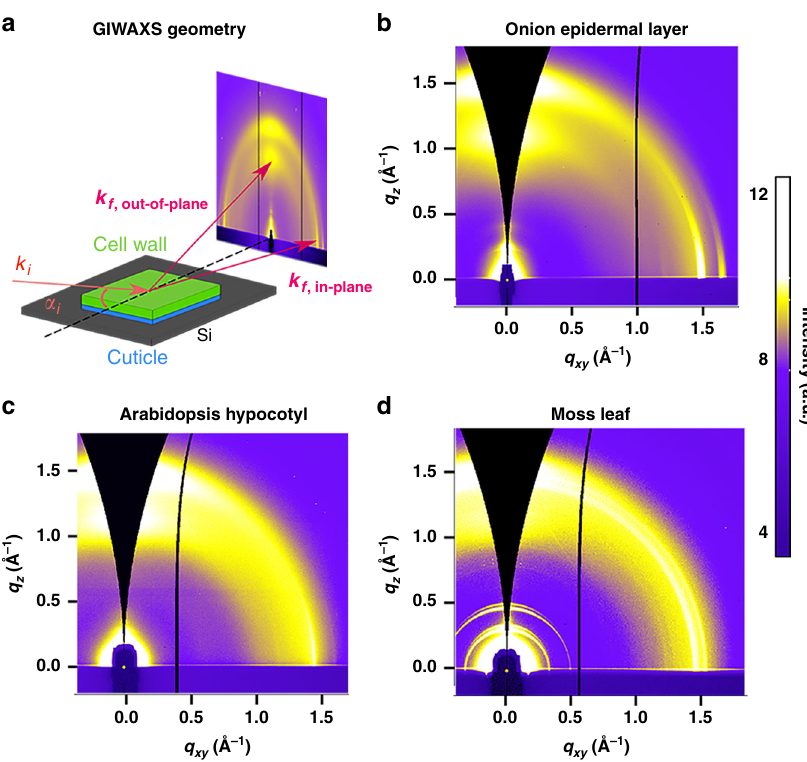
Fig. 1 GIWAXS 2D data reveal anisotropic scattering from plant primary cell walls. a GIWAXS geometry for examination of the onion epidermal cell wall ( α i : angle of incidence; k i : incident wavevector; k f ,in-plane : in-plane scattered wavevector; k f ,out-of-plane : out-of-plane scattered wavevector). GIWAXS data from b unextracted onion epidermis, c unextracted Arabidopsis hypocotyls, and d unextracted